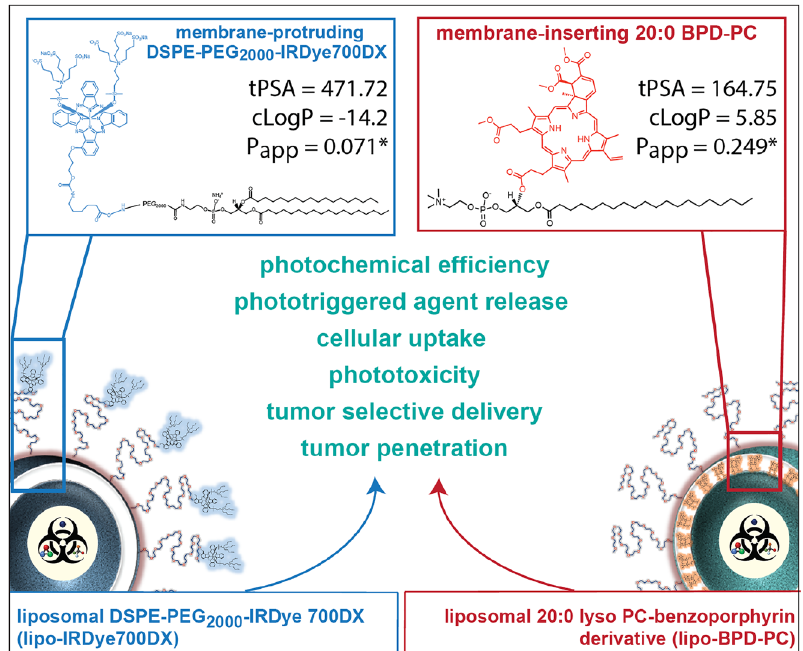
Figure 1: Graphical representation of liposomal photonanomedicines formulated with membrane-protruding DSPE-PEG- IRDye 700DX or membrane-inserting 20:0 lyso-PC-benzoporphyrin derivative (BPD-PC). Topological polar surface area (tPSA) and calculated octanol/water parti- tions (cLogP) of the PS molecules were determined using ChemDraw 18.0. The apparent biomembrane permeability co- efficients ( P app ) were simulated using pkCSM computational modeling